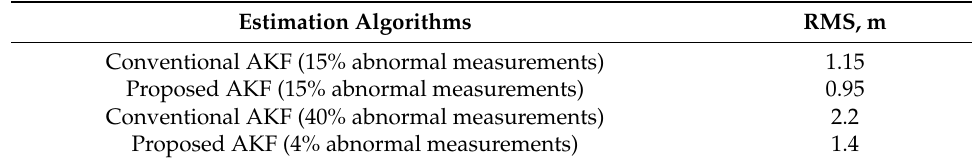
Table 5. The positioning accuracy of different estimation algorithms.